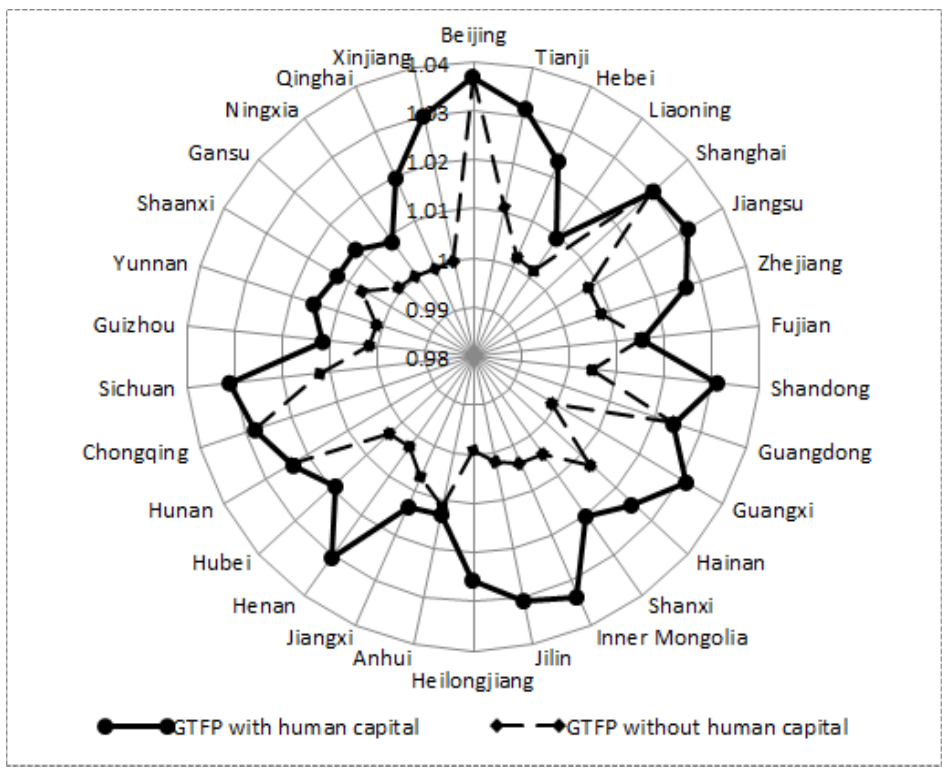
Figure 3. Comparison of GTFP among provinces and cities.